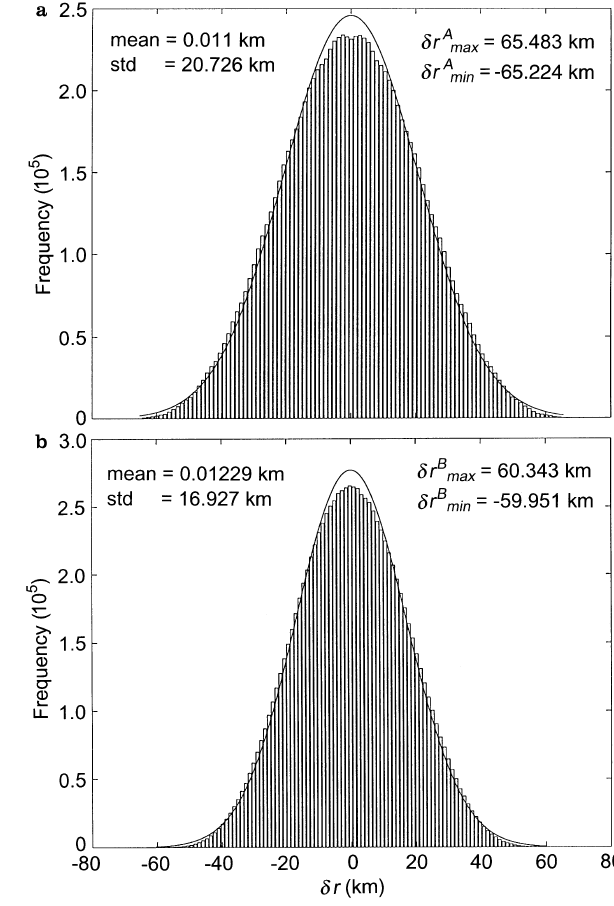
Fig. 1a,b. Histograms of the uncertainties (cid:133) (cid:100) r (cid:134) in the geocentric distance at which a magnetic field line crosses the geomagnetic (geographic) equator in the general axisymmetric case n max (cid:136) 10 for r 1 (cid:136) 2 R E : a (cid:100) r A calculated by Method A, which involves solving the 5 10 tenth-degree polynomials associated with all permutations of the